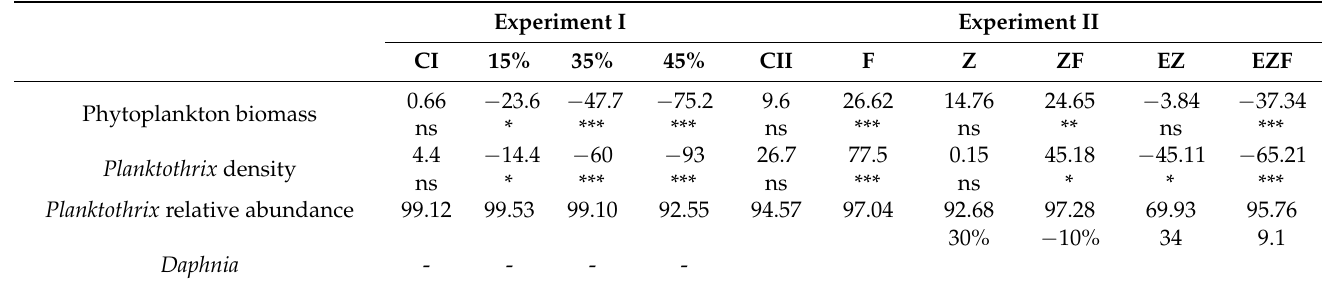
Table A1. For Experiment I, the percentages of inhibition of the phytoplankton biomass, Planktothrix density, and Planktothrix relative abundance in the control (C) and the 15%, 35%, and 45% PVI treatments